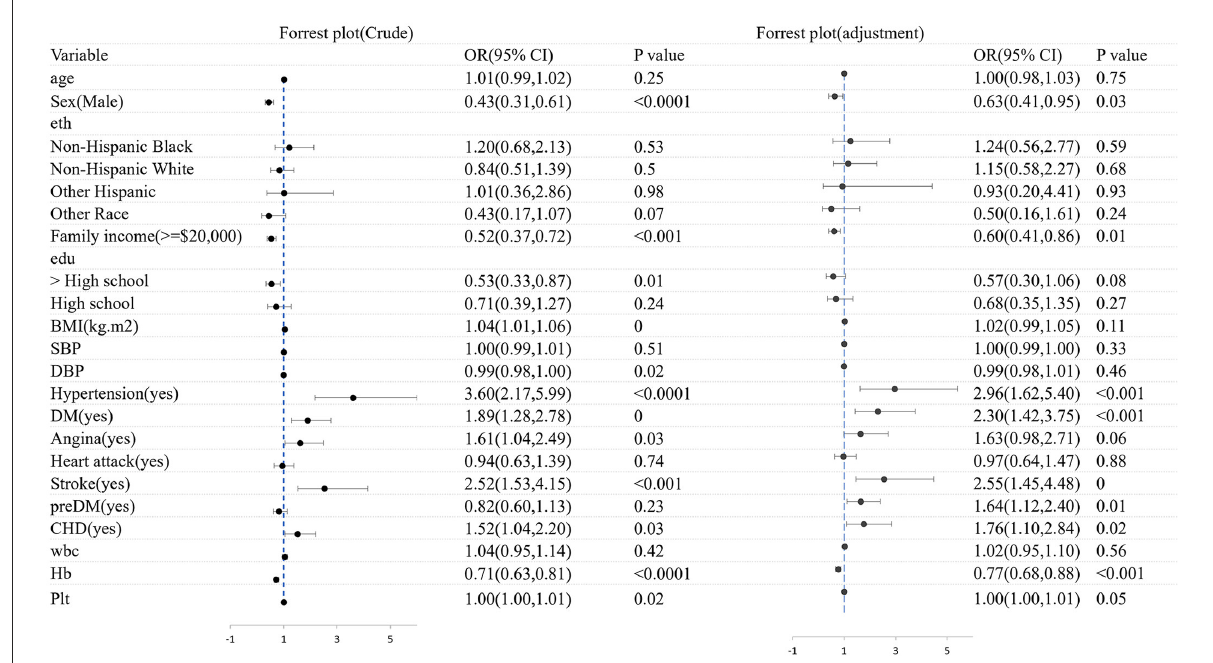
FIGURE7 The logistic regression analysis of CHF patients with frailty and non-frailty before and after adjustments for the covariates.